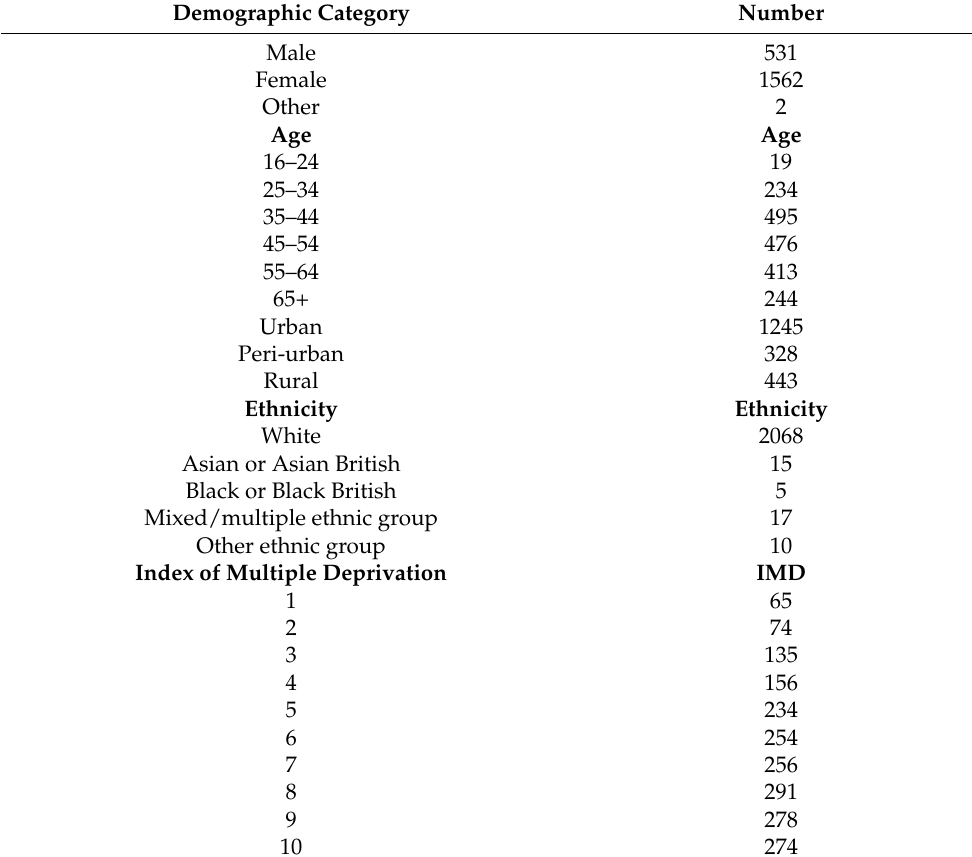
Table 1. Demographic data for